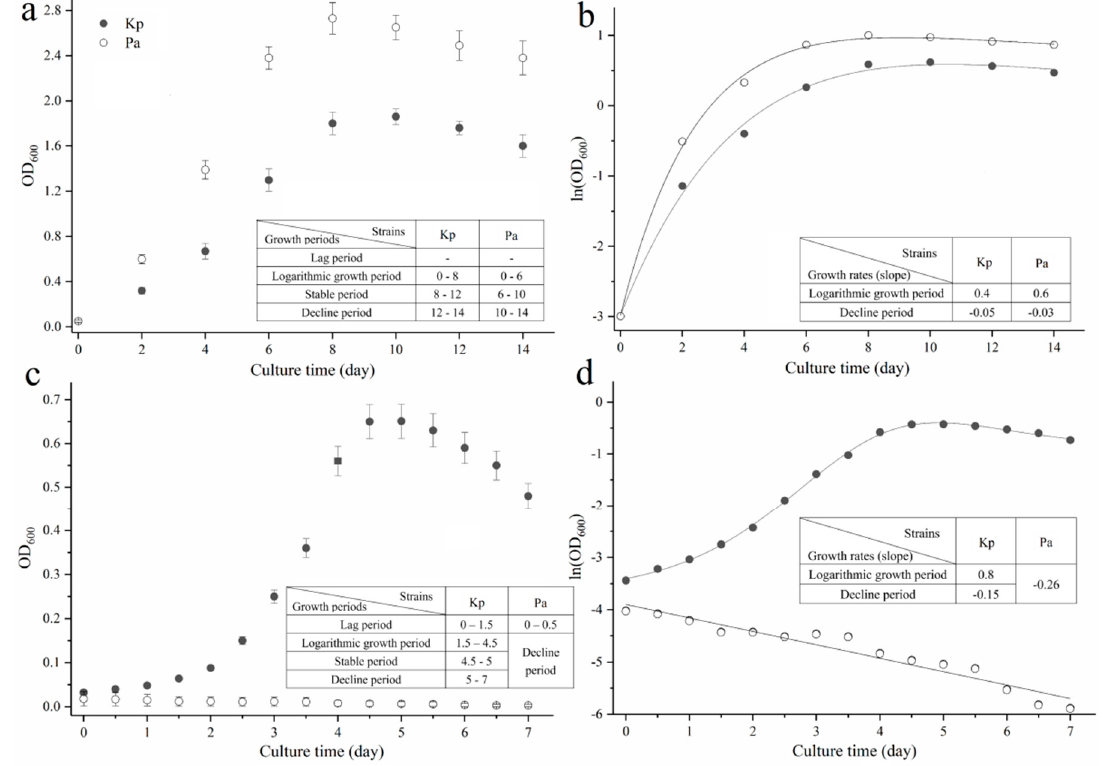
Figure 4. Growth curves of strains Kp and Pa in diesel medium ( a , b ) and cyclohexane medium ( c , d ). Data in ( a , c ) are the original values while those in ( b ) and ( d ) are the corresponding logarithmic values. Relative growth rates were estimated with the slopes during the logarithmic growth period based on the Baranyi ‐ Roberts Growth Model [64].